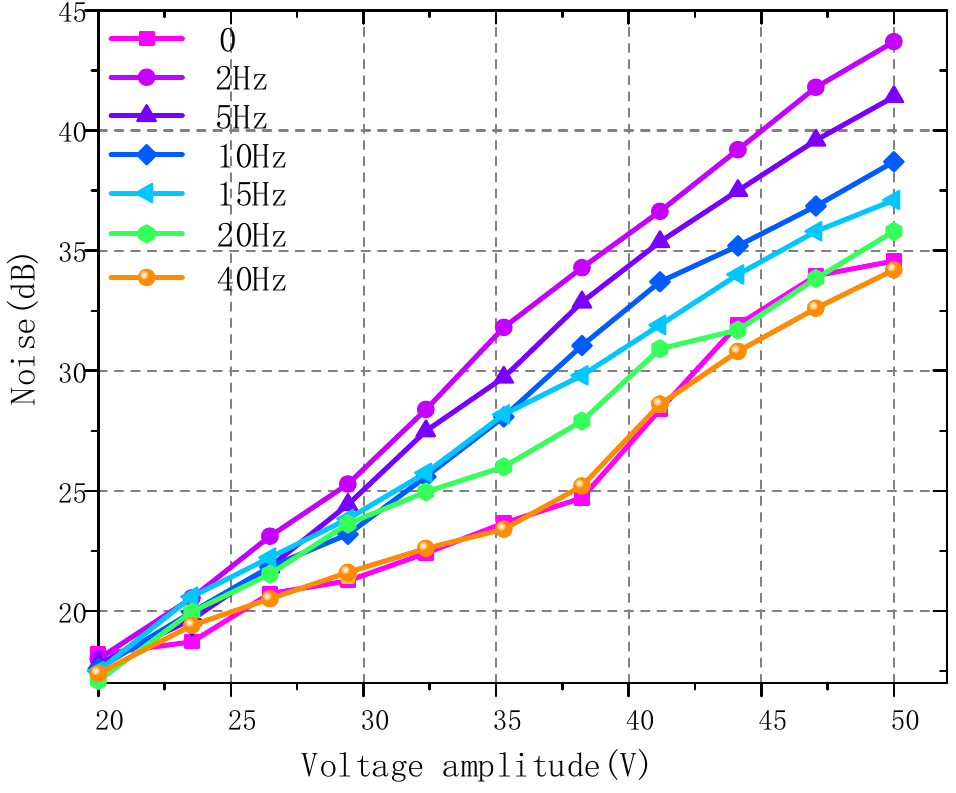
Figure 10. Noise level of iron core.